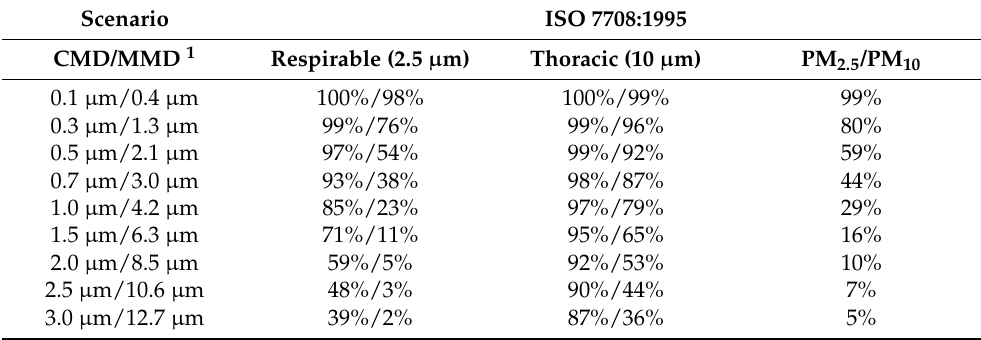
Table 3. Calculated number/mass (polydisperse) penetrations beyond the larynx (thoracic fraction) and to the unciliated airways (respirable fraction), for various count median diameters (CMDs) or mass median diameters